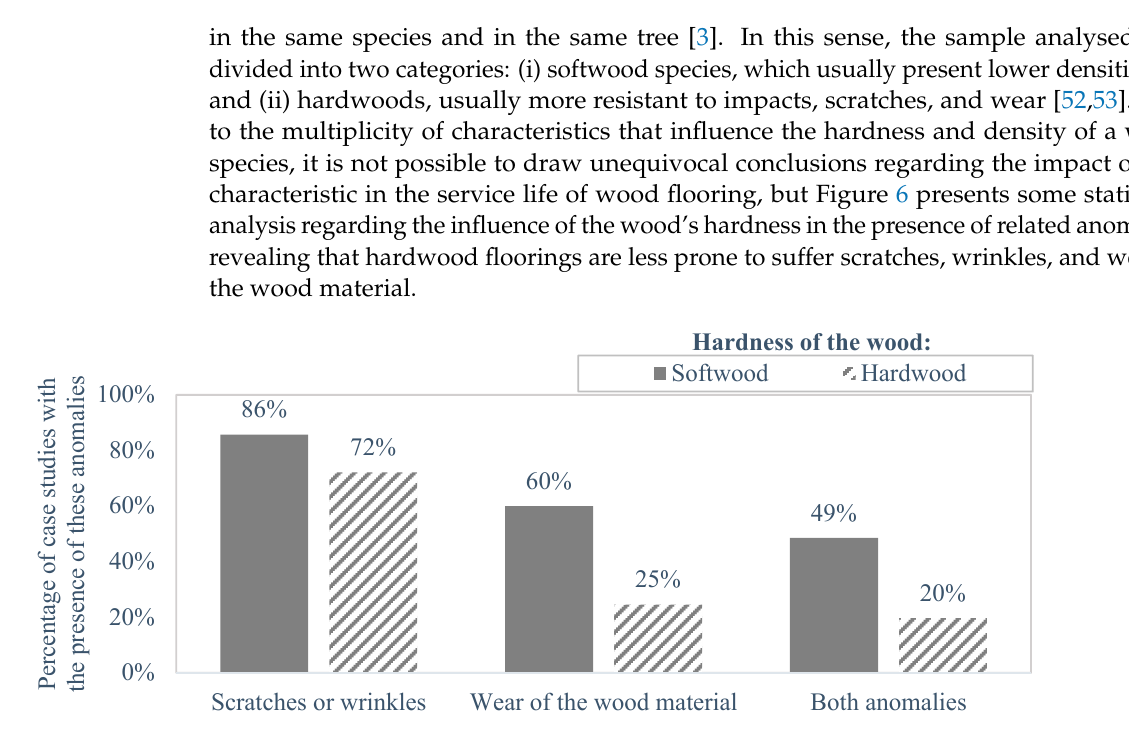
Figure 6. Statistical analysis of the presence of scratches or wrinkles and wear of the wood material, according to the hardness of the wood.